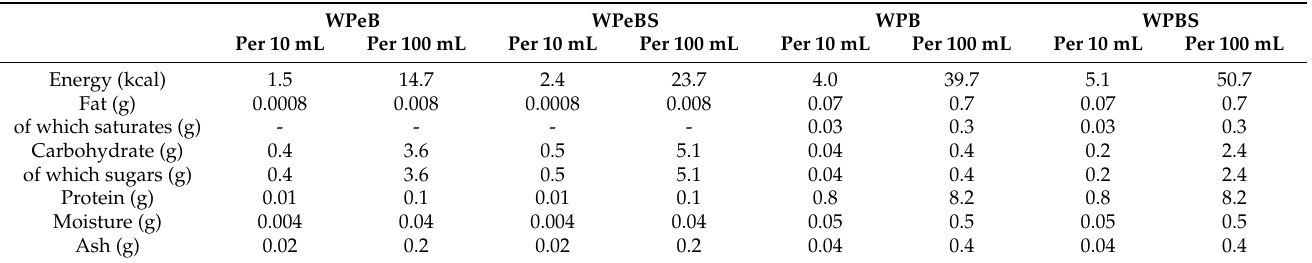
Table 2. Composition of whey beverages (WPeB: whey permeate beverage; WPeBS: whey permeate beverage sweetened; WPB: whey protein beverage; WPBS: whey protein beverage sweetened) per 10 mL (as tasted) and per 100